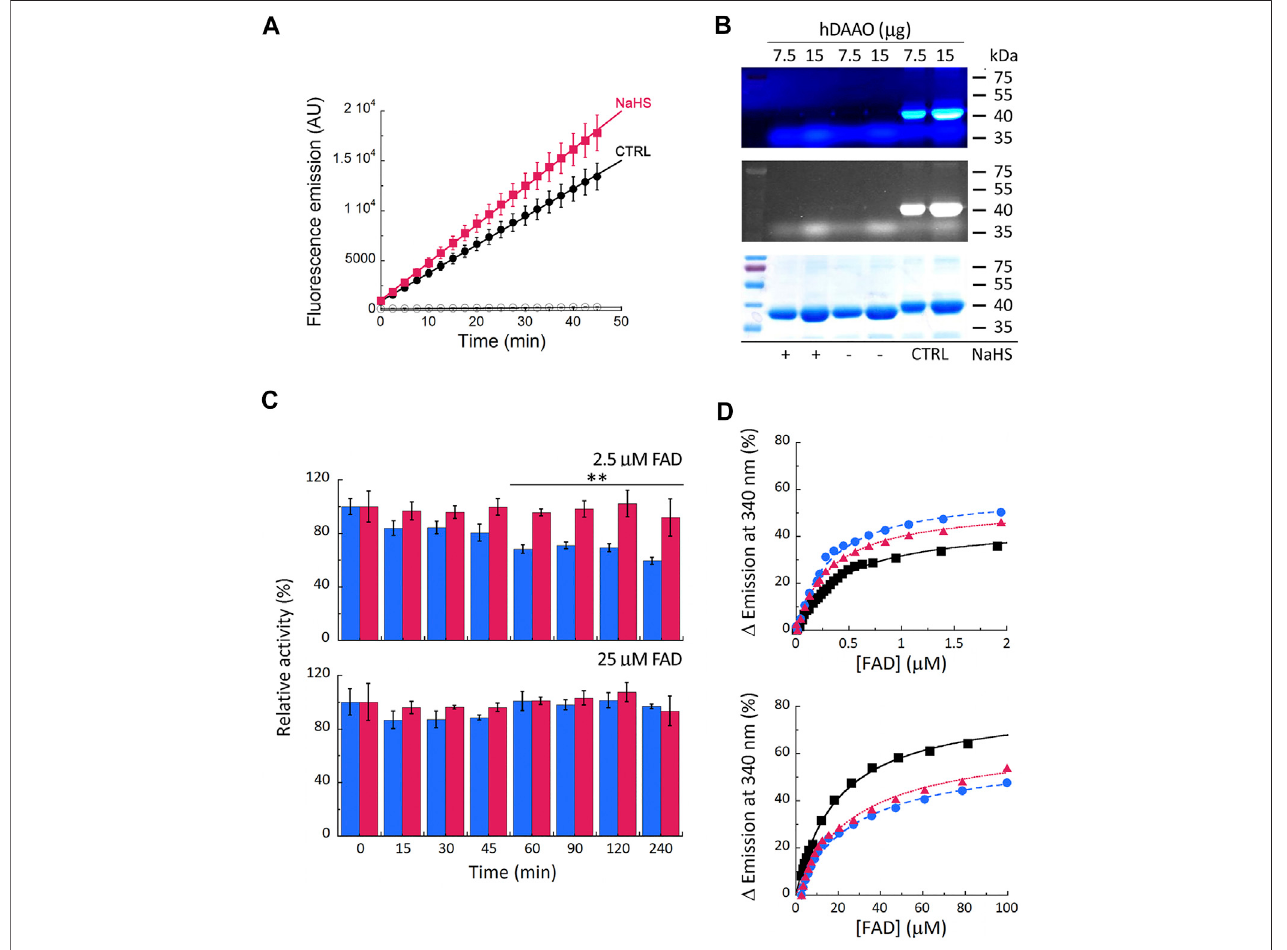
FIGURE 3 | Effect of S-sulfhydration on hDAAO properties. (A) Treatment of U87 transfected cells expressing hDAAO with the hydrogen sul fi de donor NaHS increases the activity of the fl avoenzyme. Cells were treated with 50 µM NaHS (red squares) or with an equal amount of H 2 O (CTRL, black circles) for 30 min. Cells transfected with the pcDNA3 empty vector and treated with the same amount of the H 2 S donor (open circles) were used as further controls. In treated and control cells hDAAO activity was detected in cell lysates by the Amplex UltraRed assay and reported as fl uorescence emission at 590 nm over time (0 – 45 min). Values are reported as mean ± SEM, n (cid:2) 5. (B) hDAAO is not sulfhydrated in vitro . The nonreducing SDS-PAGE analysis of recombinant hDAAO (7.5 and 15 µg) following in vitro S-sulfhydration and the fl uorescence switch assay is shown. Mixtures in which the hydrogen sul fi de donor NaHS was omitted were analyzed as negative controls whereas positive controls (CTRL) were represented by protein samples in which all cysteine residues were labeled by Alexa Fluor 350 C 5 Maleimide (see legend of Figure 2B for details). Proteins were also stained with Coomassie blue (bottom panel) . (C, D) The hydrogen sul fi de donor NaHS appears to stabilize recombinant hDAAO andaffect theFAD cofactorbinding. (C) Effectof1 mMNaHSonthetimecourseofhDAAO activity, asdetermined bytheoxygenconsumption activity assay. In vitro sulfhydration mixtures (red bars) and related controls (blue bars) were set up in the absence or presence of exogenous FAD (2.5 or 25 µM fi nal concentration). Residualactivityvalues(100%representstheinitialactivityoftheunreactedenzyme)arereportedasmean ± SEM, n (cid:2) 5,** p < 0.005,unpaired t -test. (D) AnalysisofFAD binding tohDAAO apoprotein inthe absence and presence of5 or 40 µM ofthe hydrogen sul fi de donor NaHS, assessed as protein fl uorescence quenching. Values are expressed as percentage of the total change. Top panel shows the interpolation of the experimental data corresponding to the fi rst saturation phase of the protein fl uorescencechange(upto2 µMofcofactorconcentration);bottompanelreportsthesameanalysisforthesecondphaseofsaturation.Measurementswereperformed at 15 ° C. Black squares and continuouslines: control mixture in the absence ofNaHS; blue circles and staggered lines: mixture containing 5 µM NaHS; red trianglesand dotted lines: mixture containing 40 µM NaHS.